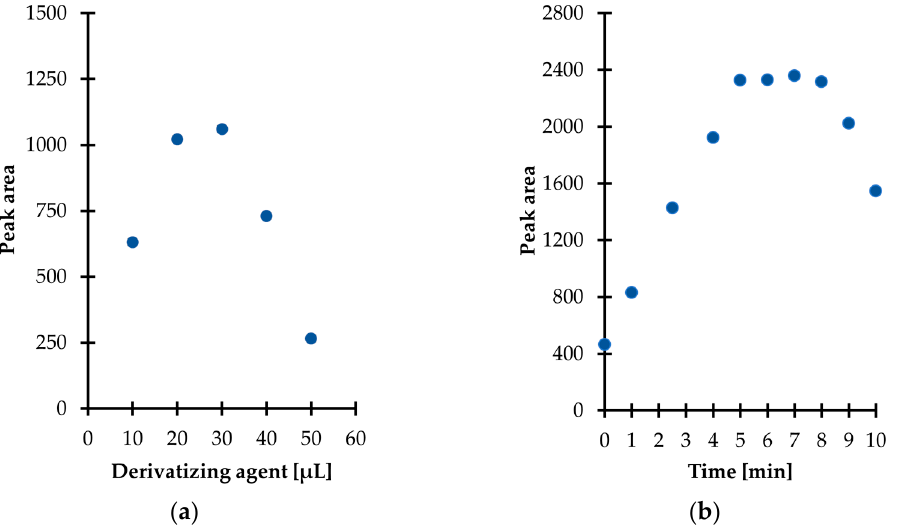
Figure 3. Derivatization reaction yield as a function of ( a ) the amount of the reagent; ( b ) time combined with examination of the isobutyl derivative of 1,3-thiazinane-4-carboxylic acid (TCA-IBCF) stability in the aqueous phase, expressed as a peak area of the derivative. Samples were analyzed according to the procedure described in Section 3.6.